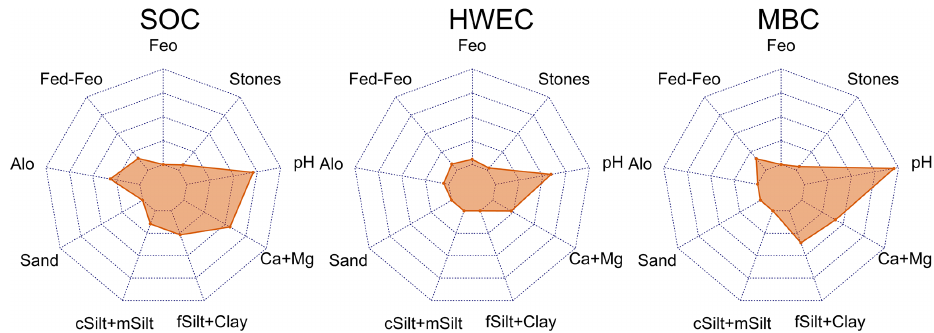
Figure 5. Comparison of the coefficient impact for mixed-effect models to predict SOC, HWEC and MBC for the entire dataset by using parent material as a random factor. Variables are scaled from 0 to